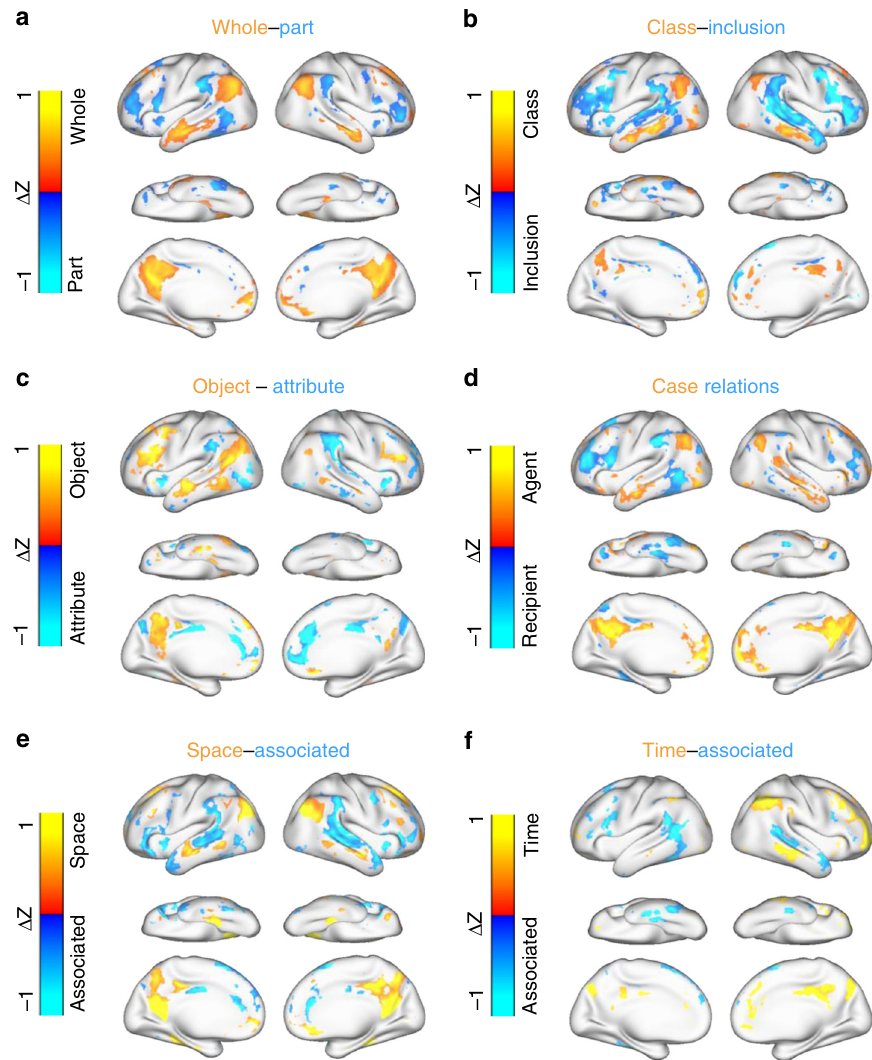
Fig. 7 Cortical representations of semantic relations. The cortical pattern associated with each relation shows the average cortical projection of every word-pair sample in that relation and highlights only the voxels of statistical signi fi cance (paired permutation test, two-sided, FDR q < 0 : 05) based on voxel- wise univariate analysis. For each of the six relations in this fi gure, see Supplementary Table 4 for summary statistics and also see Supplementary Fig. 9 for the results about other